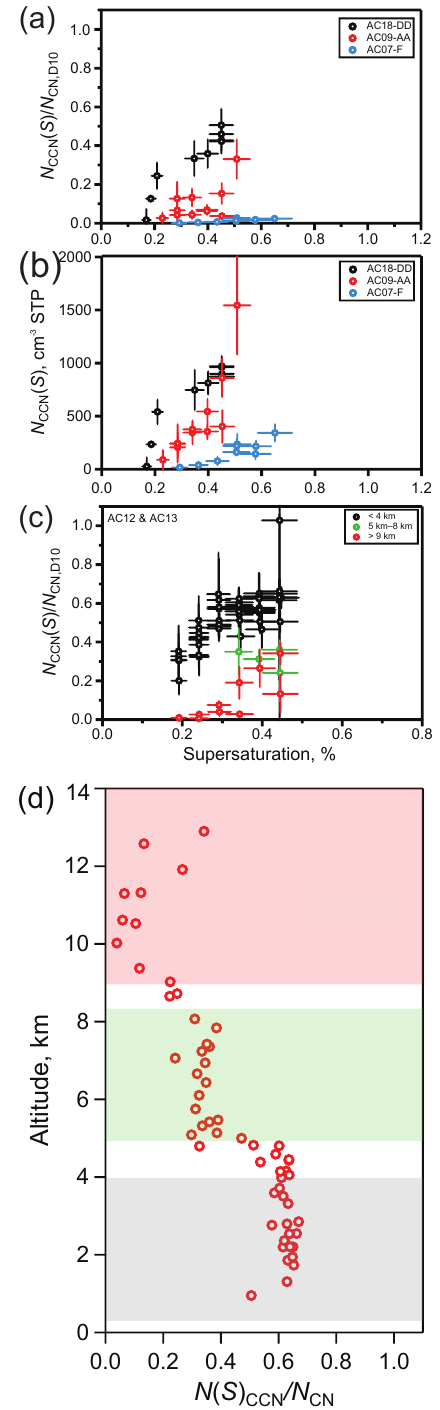
Figure 13. (a) CCN fractions ( N CCN0 . 5 /N CN ) and (b) CCN con- centrations ( N CCN0 . 5 ) vs. supersaturation from selected legs from flights AC07, AC09, and AC18; (c, d) data from flights AC12 and AC13 for the LT, MT, and